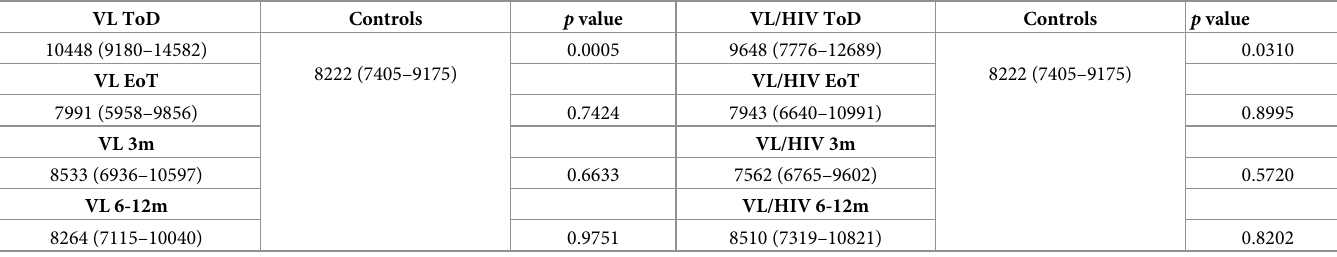
Table 2. Comparison of neutrophil CD63 expression levels between VL and VL/HIV patients and controls over time. VL ToD Controls p value